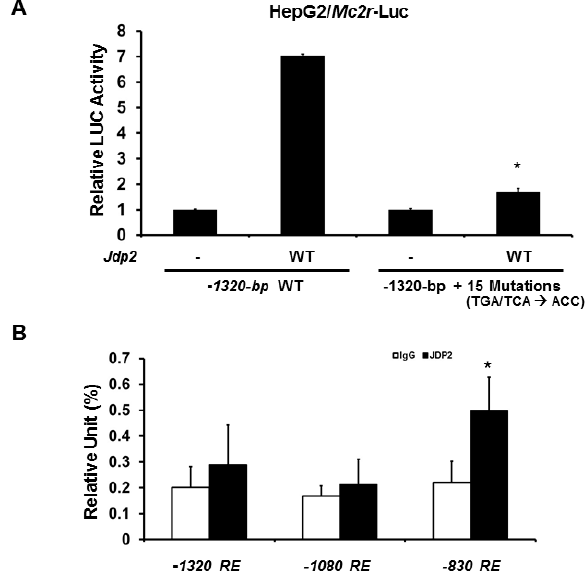
Figure 4. Mutations of cAMP response elements significantly reduce JDP2-mediated Mc2r promoter activity. ( A ) HepG2 cells were co-transfected Jdp2 expression plasmid and with either wild-type or cAMP response element mutated Mc2r promoter − 1320-bp constructs. Forty-eight hours after transfection, luciferase activities (LUC) were measured and normalized with Renilla activity. Relative LUC activity (presented as fold activation) was calculated and plotted on a graph. The experiments were performed three times in triplicate setting. Error bars indicate the standard error. * indicates two-tailed t test p < 0.05 vs. wild-type − 1320-bp construct; ( B ) Quantification of the amounts of DNA precipitated, expressed as a percentage of the total input DNA, in ChIP analysis of JDP2-binding sites in the promoter region (between − 3120 and − 720-bp) of Mc2r in Y1 cells. The experiments were performed three times. * indicates two-tailed t test p < 0.05 vs. IgG. RE: response